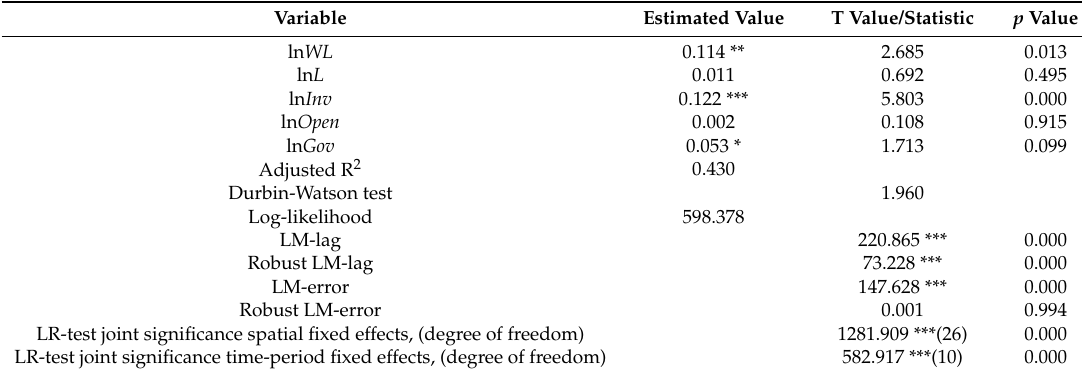
Table 6. Results of non-spatial panel model regression and related tests.